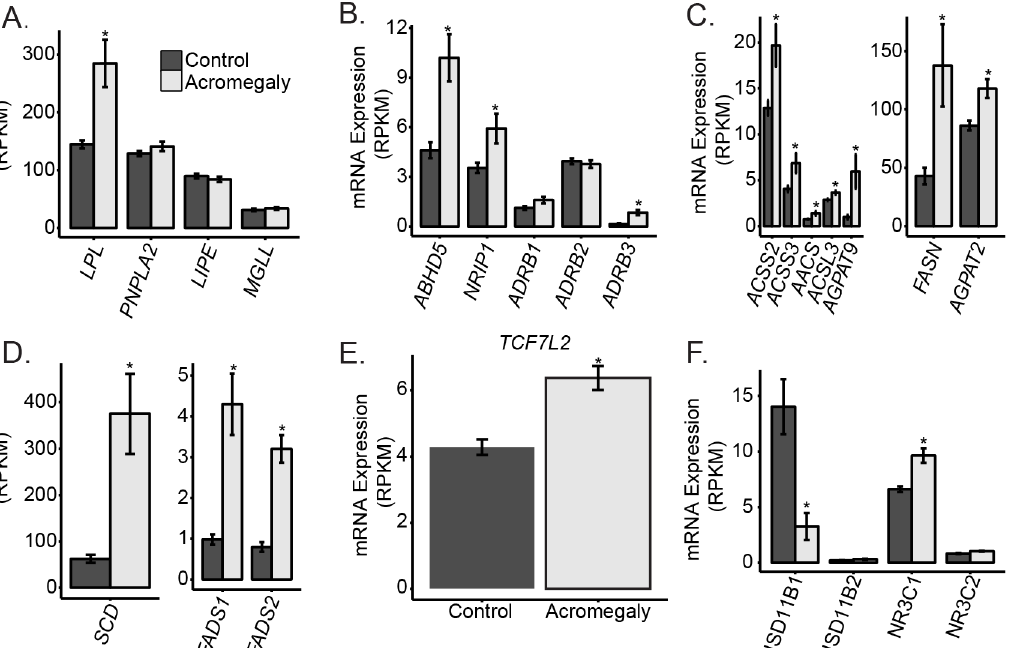
Fig 4. Expression changes of selected genes, potentially responsible for lipolytic or insulin sensitivity alterations in acromegaly patients. mRNA Expression profile of genes potentially involved in lipid catabolism (A), regulation of lipolysis (B), fatty acid synthesis (C), fatty acid desaturation (D), TCF7L2 (E), and glucocorticoid signaling (F). Asterisks indicate q < 0.05. Data indicates mean +/- standard error of the